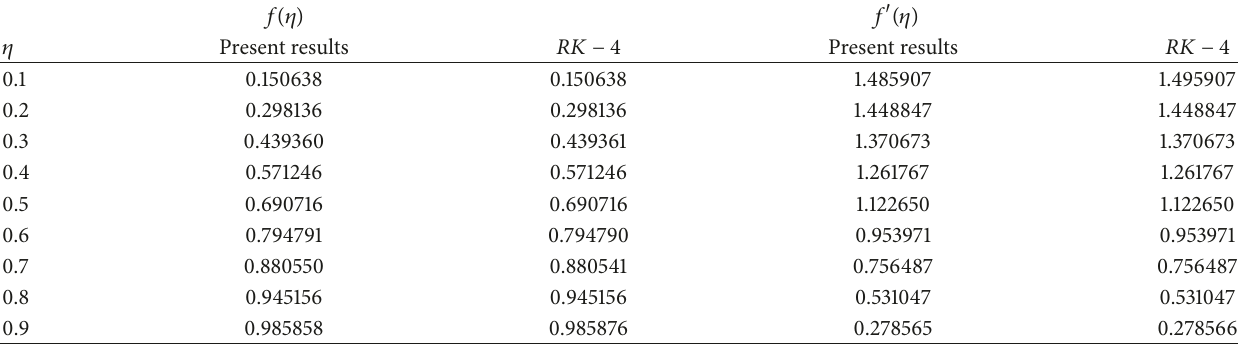
Table 6: Comparison between the solution of present algorithm and 𝑅𝐾 − 4 algorithm for 𝑀 = 1 , 𝛾 = 0.2 , 𝑆 = −1